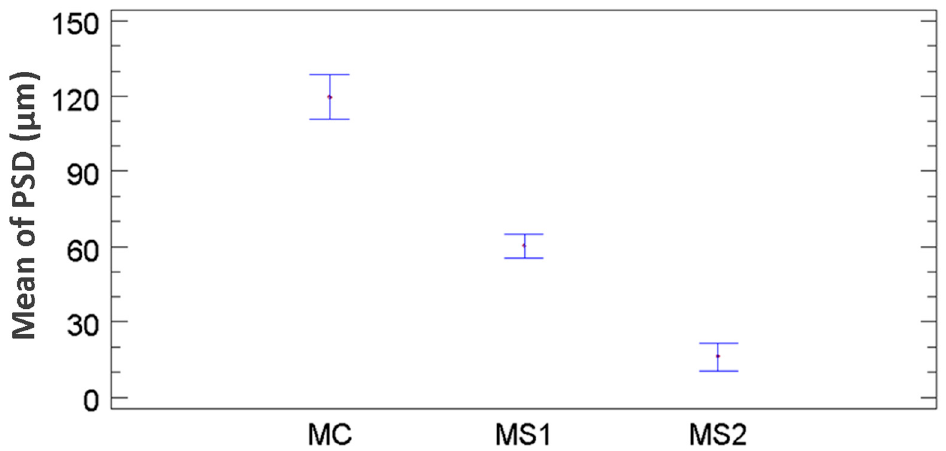
Figure 6. Tukey’s HDS plot for comparison of PSD between optical microscopy and laser diffraction technique with and without pre-treatment.